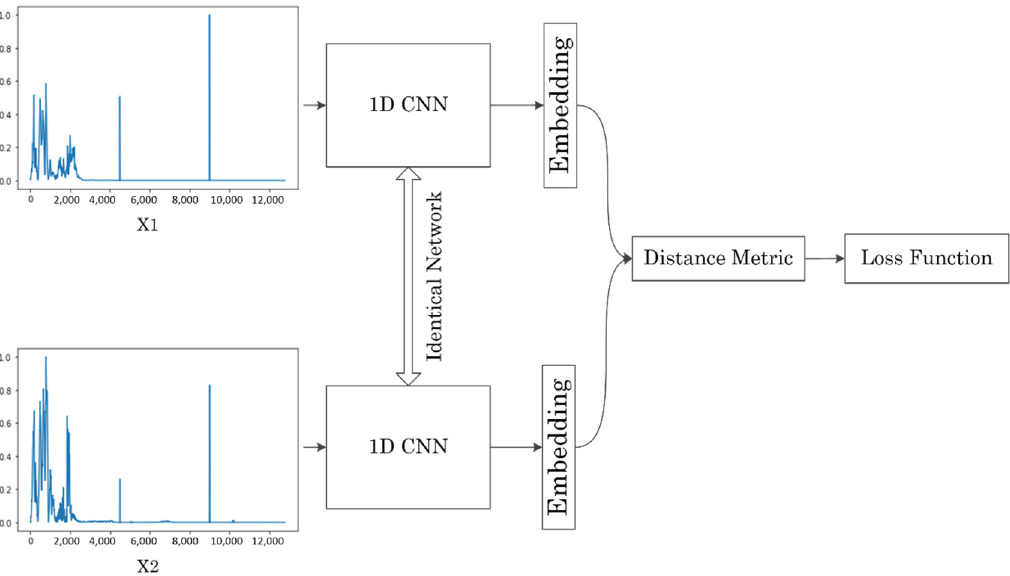
Figure 1. Siamese neural network architecture.